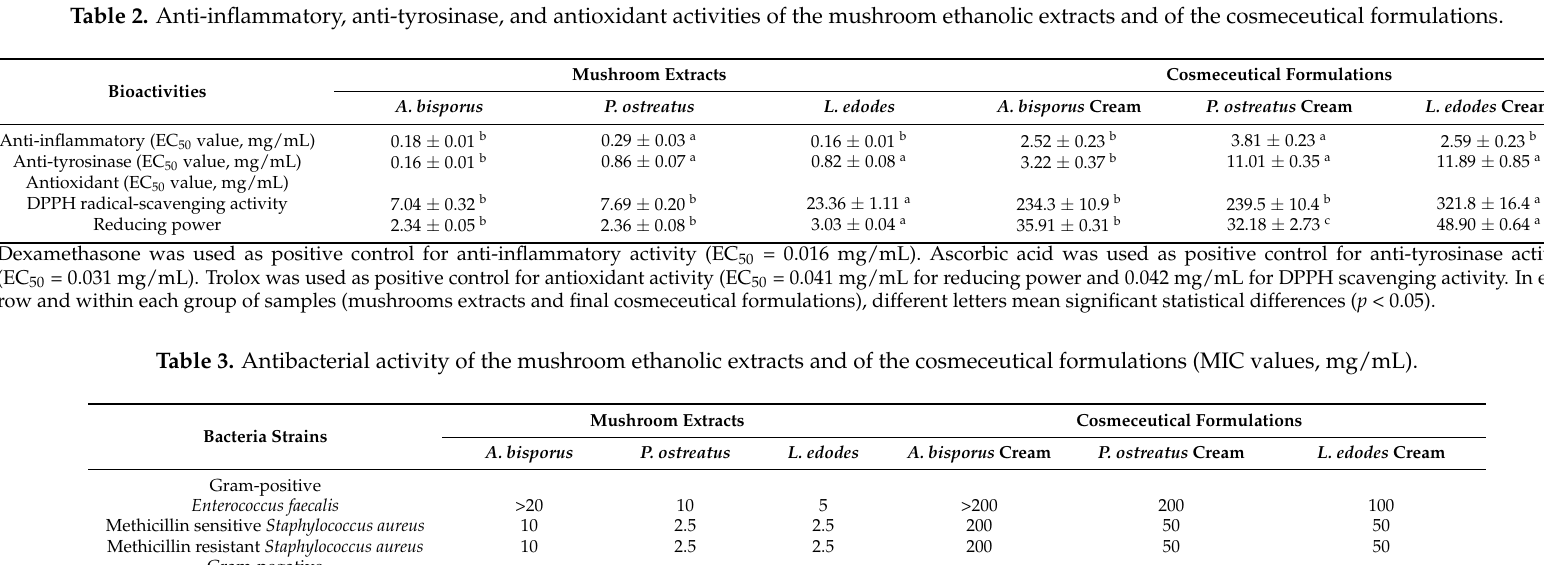
MIC—minimal inhibitory